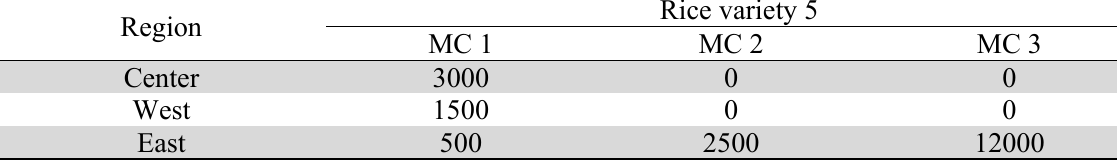
Optimal paddy flow between farmlands (regions) and milling